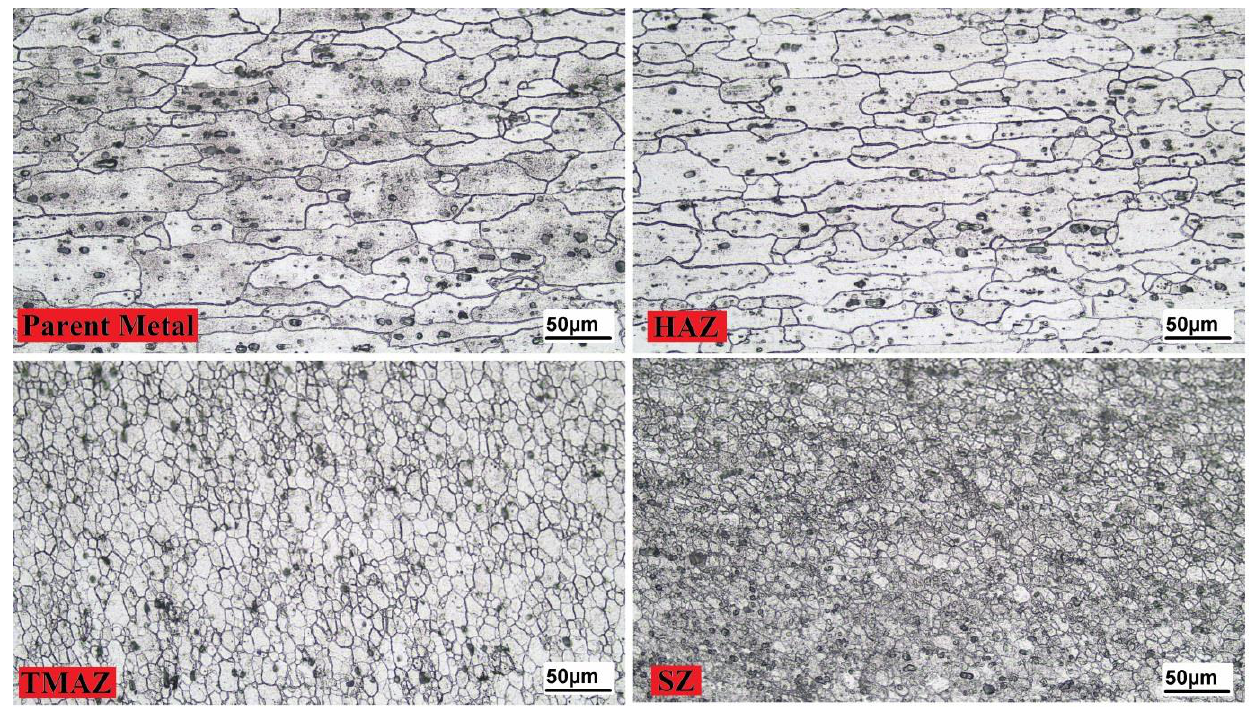
Figure 12. Hardness profiles of RP-FSW specimens with different tool offsets.